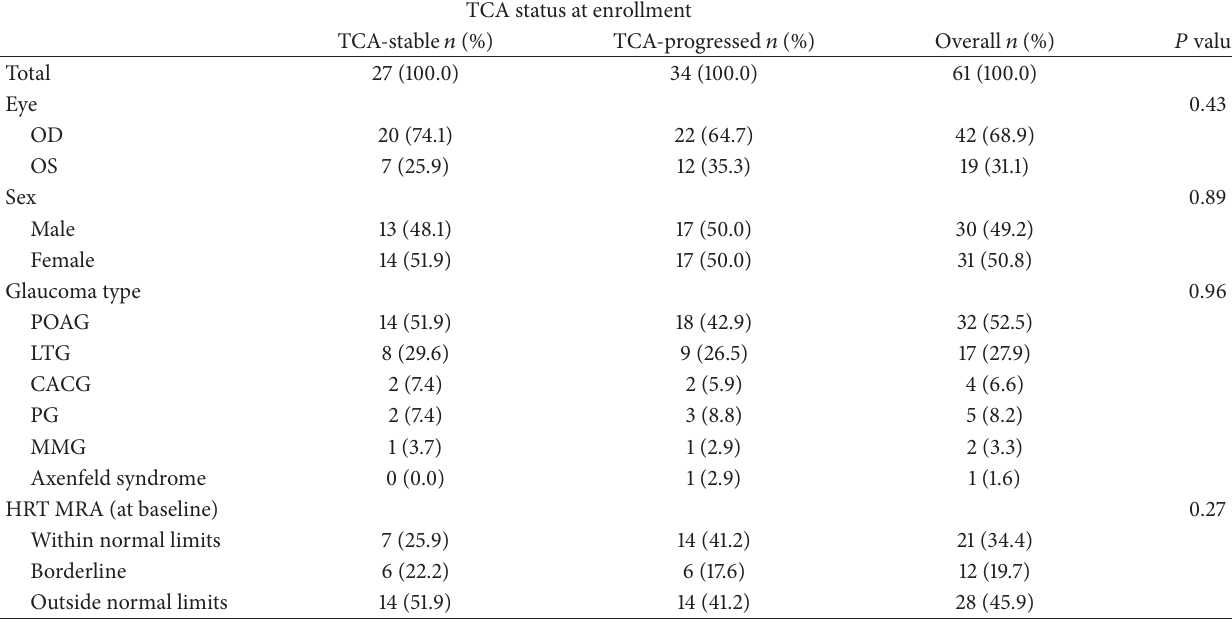
Table 1: Descriptive characteristics of study eyes/patients by HRT TCA status at enrollment.